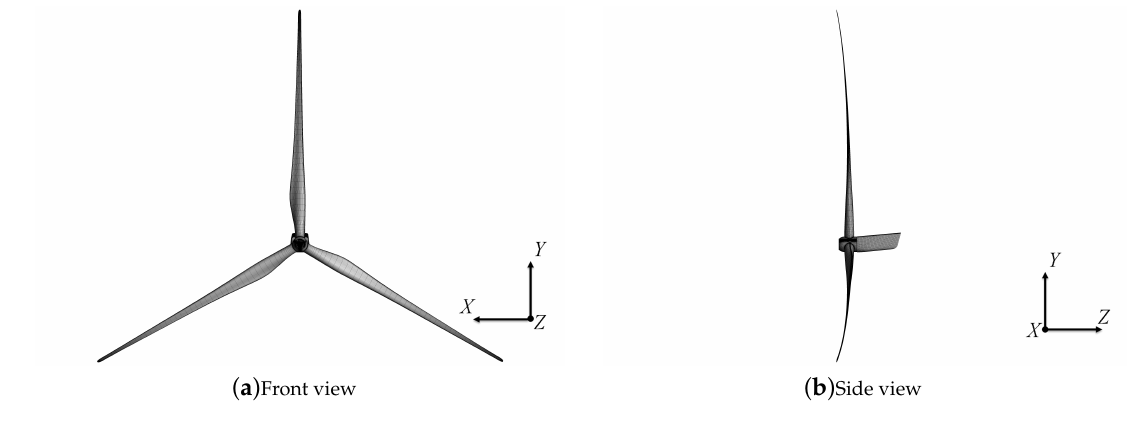
Figure 1. Computational